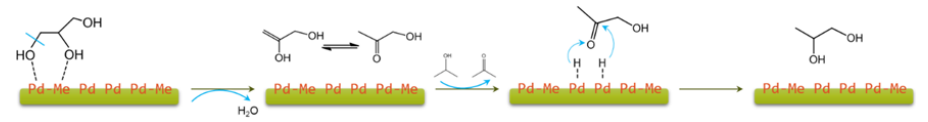
Table 1. Catalytic transfer hydrogenolysis of glycerol to 1,2 ‐